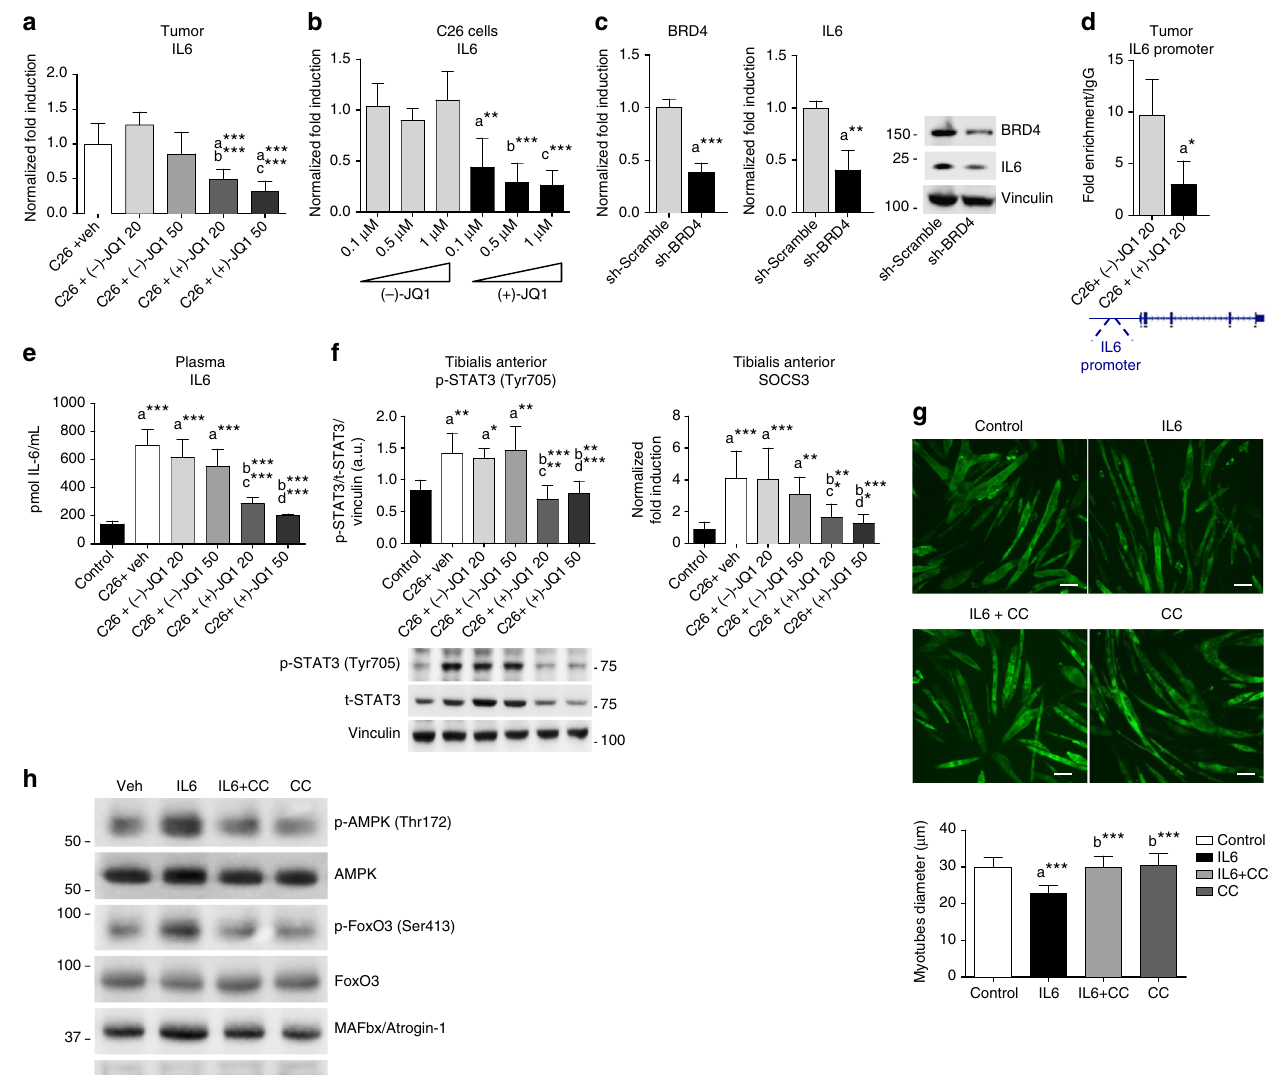
Fig. 5 JQ1 administration lowers circulating and tumor-producing IL6 levels. a Tumor-derived IL6 transcripts (means ± SD) were measured by quantitative RT-PCR. Statistical analysis: one-way ANOVA, Tukey ’ s post hoc test. *** p < 0.001. “ a ” , “ b ” , “ c ” indicate statistical signi fi cance vs. C26 + vehicle, C26 + ( − )-JQ1 20 mg/kg/day and C26 + ( − )-JQ1 50 mg/kg/day, respectively. b C26 cells were treated with different doses of ( − )-JQ1 and (+)-JQ1, and IL6 transcripts were measured by qRT-PCR. Mean ± SD, n = 5. Statistical analysis: one-way ANOVA, Tukey ’ s post hoc test. ** p < 0.01; *** p < 0.001. “ a ” , “ b ” , “ c ” indicate statistical signi fi cance vs. C26 cells treated with ( − )-JQ1 0.1, 0.5, and 1 μ M, respectively. c C26 cells were transduced with Sh-scramble or Sh- BRD4 retroviruses, and BRD4 and IL6 transcripts were measured by qRT-PCR. Mean ± SD, n = 5. Statistical analysis: Student ’ s unpaired t -test. ** p < 0.01; *** p < 0.001. Right panel: BRD4 and IL6 immunoblots of Sh-Scramble and Sh-BRD4 C26 cells. d BRD4 recruitment at IL6 promoter was measured by ChIP in tumors from ( − )-JQ1- and (+)-JQ1-treated (20 mg/kg/day) mice. Means ± SEM, n = 3. Statistical analysis: Student ’ s unpaired t -test. * p < 0.05. e ELISA on plasma IL6 in control and C26-bearing mice treated with vehicle, ( − )-JQ1 and (+)-JQ1 at 20 and 50 mg/kg/day. n = 5. Statistical analysis: one-way ANOVA, Tukey ’ s post hoc test. *** p < 0.001. Data represent means ± SD. “ a ” , “ b ” , “ c ” , and “ d ” indicate statistical signi fi cance vs. control, C26 + vehicle, C26 + ( − )-JQ1 20 mg/kg/day and C26 + ( − )-JQ1 50 mg/kg/day, respectively. f p-STAT3 and SOCS3 were analyzed in TAs. Left panel: p-STAT3 (Tyr705) and t-STAT3 were evaluated by western blot. Means ± SD, n = 6. Right panel: SOCS3 levels were quanti fi ed by quantitative RT-PCR. Means ± SD, n = 8. Statistical analysis: one-way ANOVA, Tukey ’ s post hoc test. * p < 0.05; ** p < 0.01; *** p < 0.001. “ a ” , “ b ” , “ c ” , and “ d ” indicate statistical signi fi cance as in e . g C2C12 myotubes were treated with IL6, Compound C/IL6, or Compound C alone for 48 h. Cells were immunostained with MyHC (MF20) antibody. Scale bar: 50 μ m. Lower panel: average diameter size of myotubes. Means ± SD, n = 3. Statistical analysis: one-way ANOVA, Tukey ’ s post hoc test. *** p < 0.001. “ a ” , “ b ” indicates statistical signi fi cance vs. control and IL6-treated cells, respectively. h Cells were treated as in g and p-AMPK (Thr172), total AMPK, p-FoxO3 (Ser413), total FoxO3, and Atrogin1/MAFbx were analyzed by western blot. GAPDH serves as loading control ( n = 3)